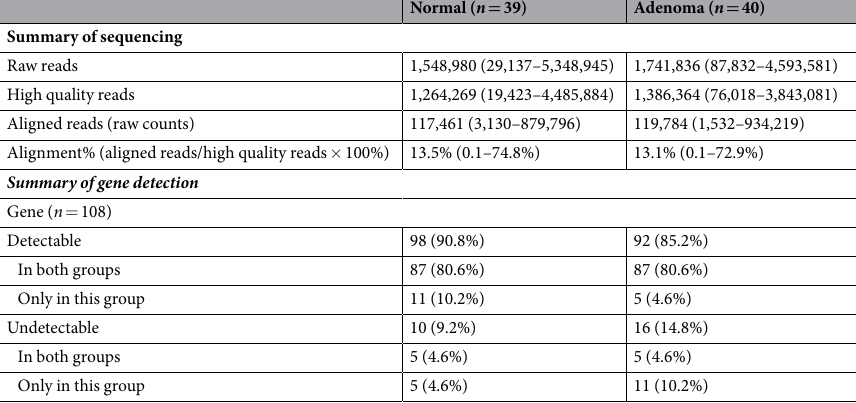
Table 1. The summary of sequencing (median [range]) and gene detection (gene number